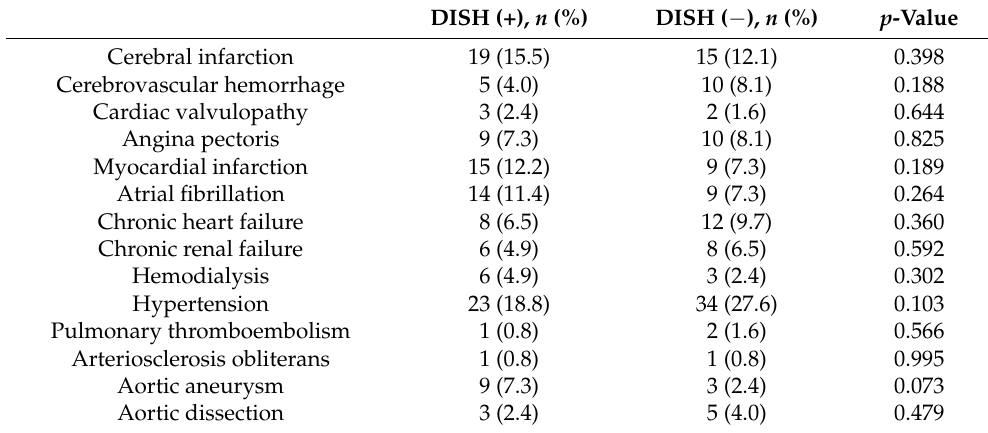
Table 4. Medical history regarding cardiovascular